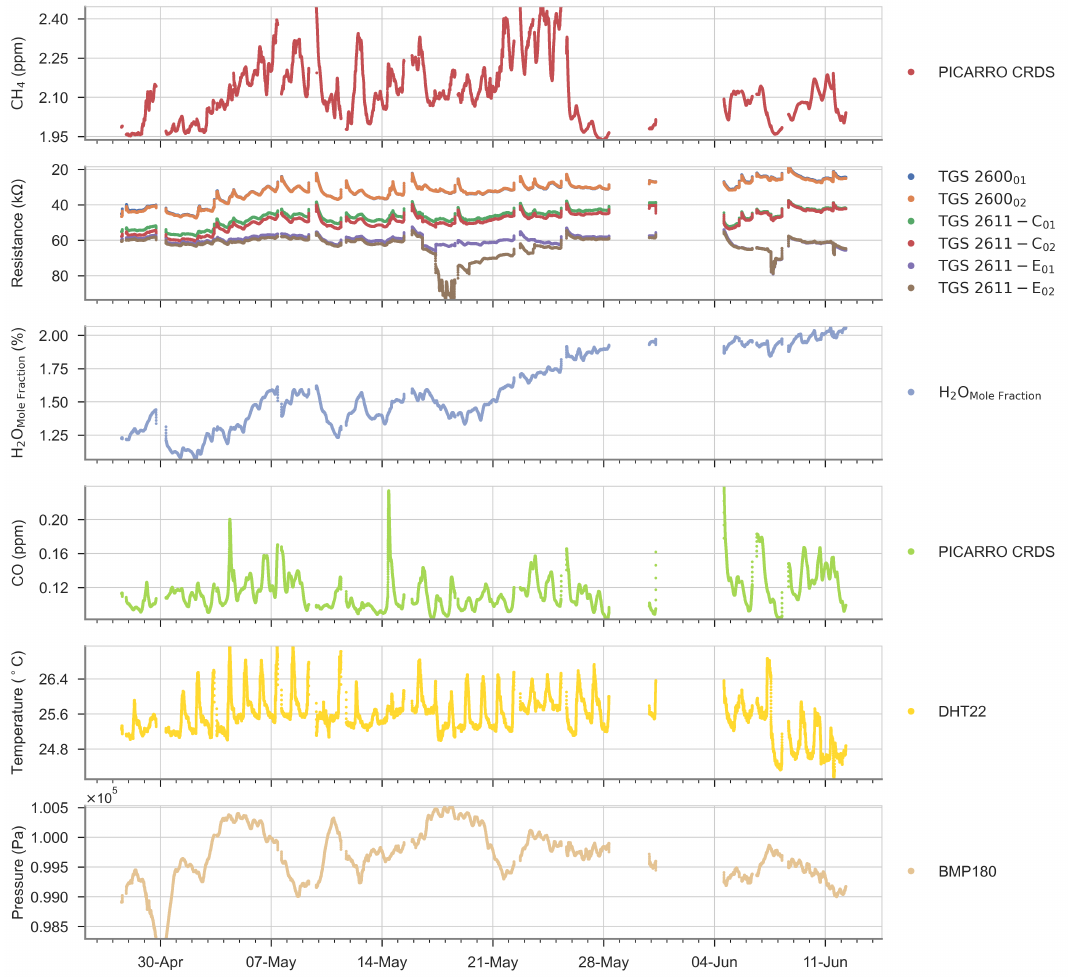
Figure 5. Time series of gas mole fractions, Figaro ® sensors’ resistances, temperature and pressure in room air during the room air experiment. The data was filtered as explained in Section 4.2.